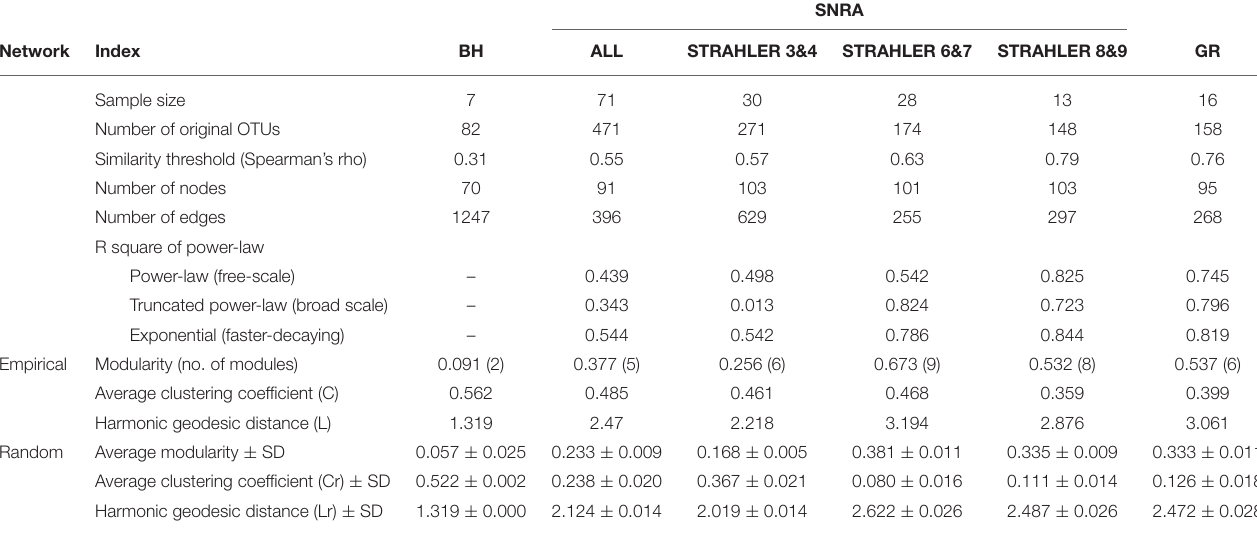
TABLE 3 | Topological properties of molecular ecological networks (MENs) of microbial communities.